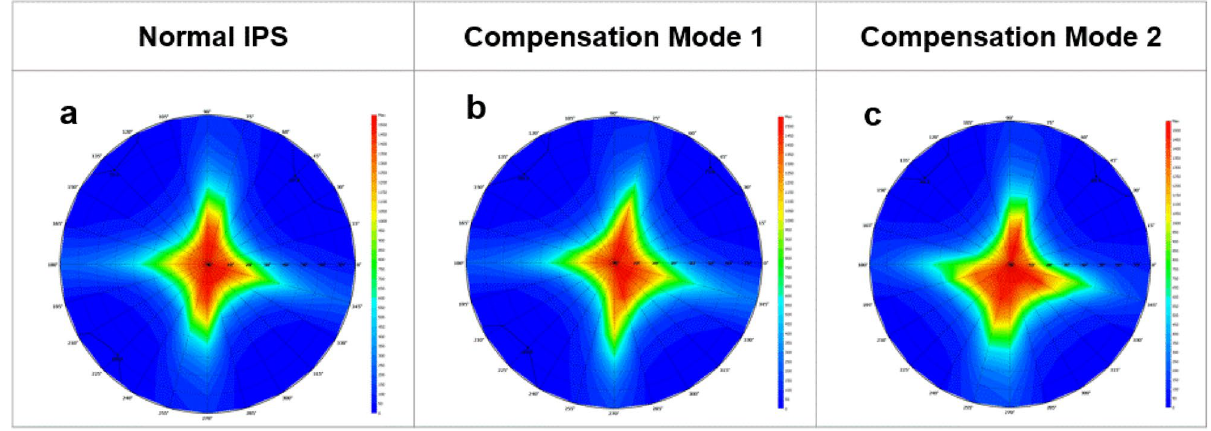
Figure 4. The CR of ( a ) normal IPS, ( b ) the compensation mode 1, and ( c ) the compensation mode